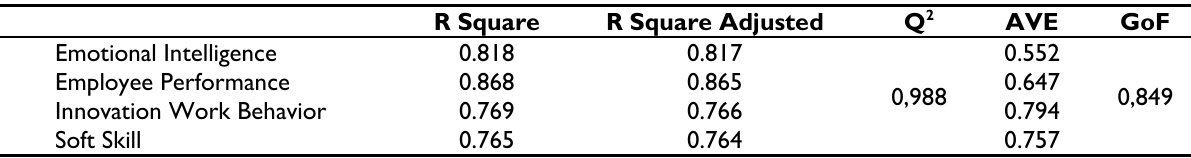
Table 3. Inner Model Test Results for Research Variables